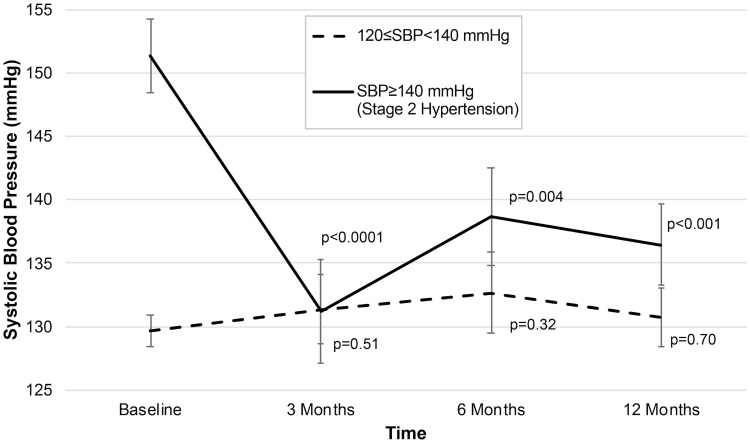
Changes in systolic blood pressure (SBP) from baseline through follow-up after MB-BP intervention.Analyses were performed using hierarchical linear models. P-values represent comparison of respective follow-up time to baseline. Error bars are standard errors of the mean. Error bars represent standard error of the mean. P-values compare follow-up times to baseline. Sample sizes for comparisons at 3, 6 and 12 months vs. baseline are 20, 18, and 19, respectively, for participants with SBP≥140, and 24, 23, and 24, respectively, for participants with SBP≥120 and <140 mmHg.